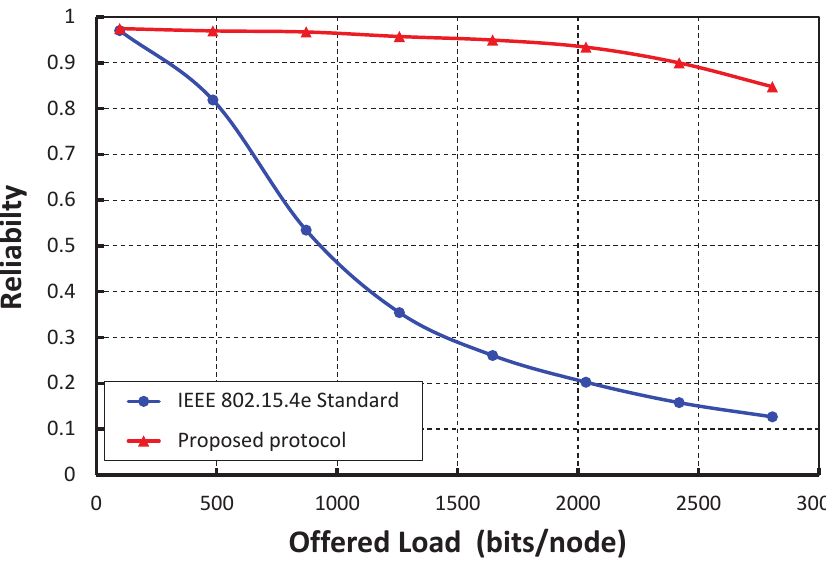
Figure 16. Comparison of reliability of our protocol with the IEEE 802.15.4e standard.